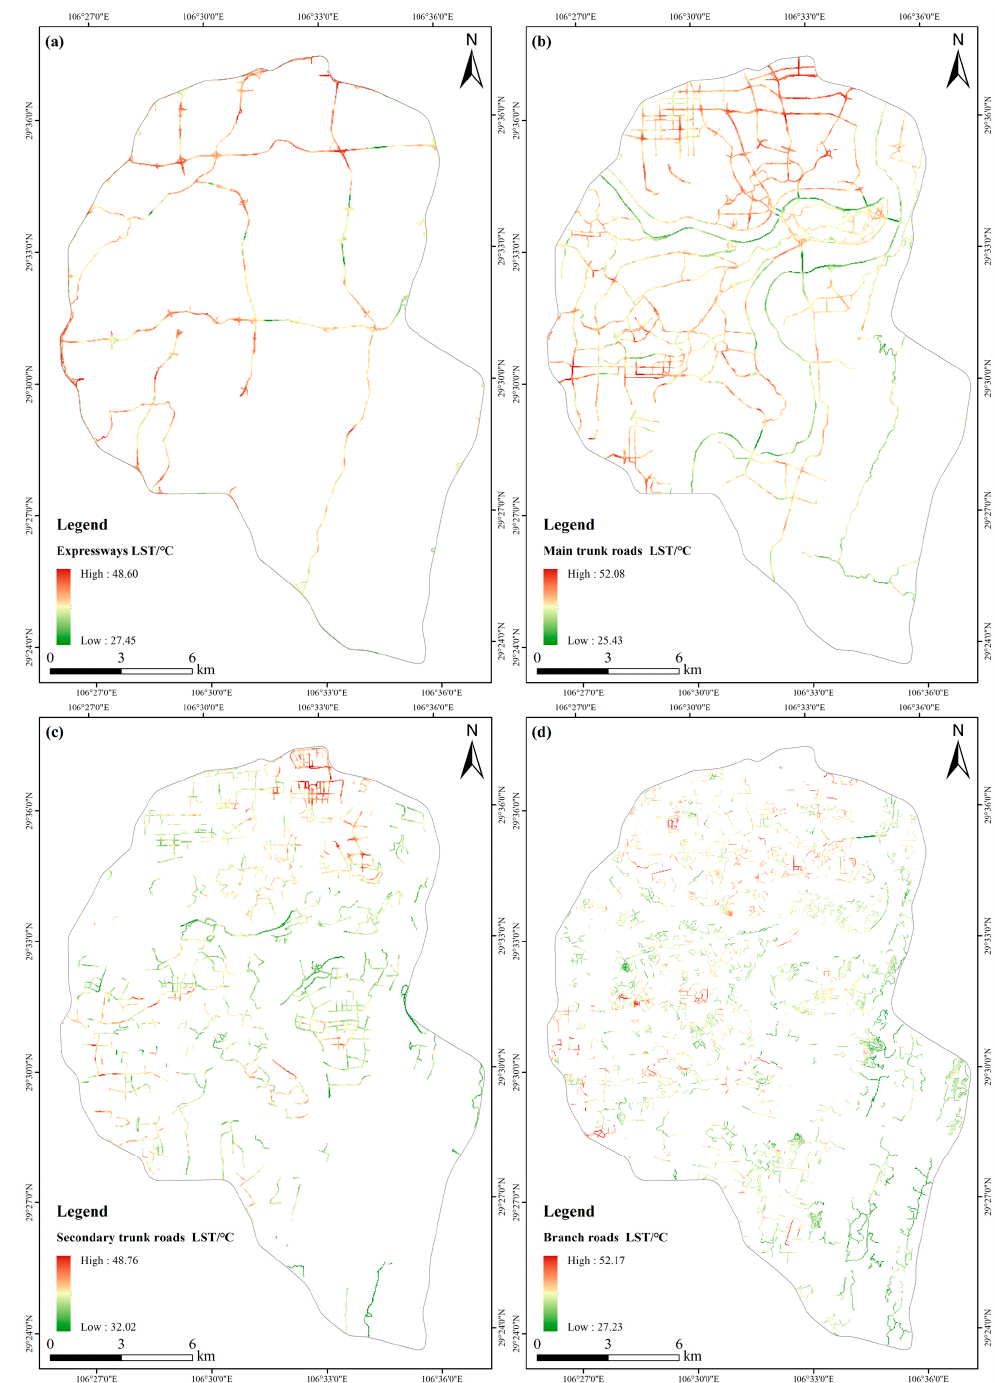
Figure 7. Spatial distribution map of streets’ LST of different types: ( a ) Expressways; ( b ) Main trunk roads; ( c ) Secondary trunk roads; ( d ) Branch roads.